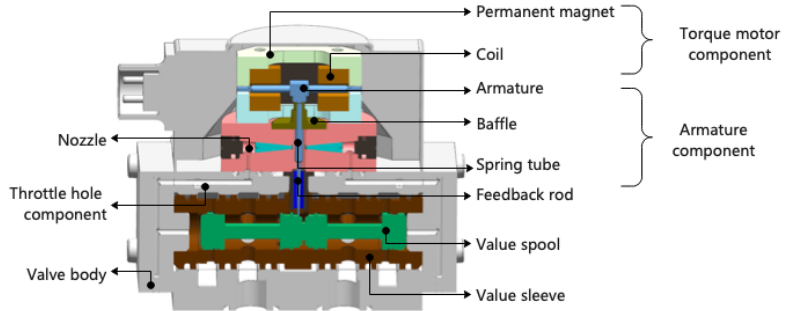
Figure 6. The key internal structure of the servo valve.